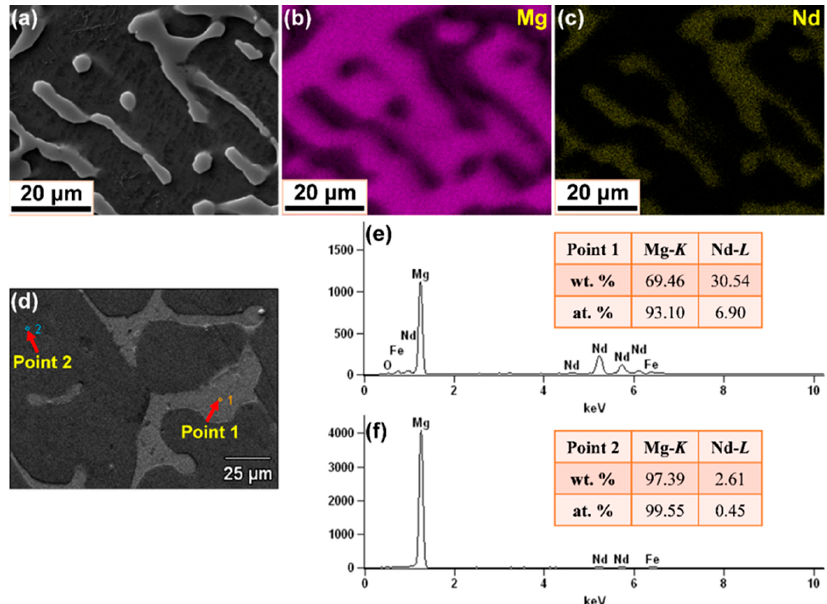
Figure 6. Micrographs and chemical composition analysis of Mg–6Nd alloy: ( a – c ) BSE image and corresponding elemental mappings; ( d – f ) SEM image and point EDS results of the secondary phase and Mg matrix.